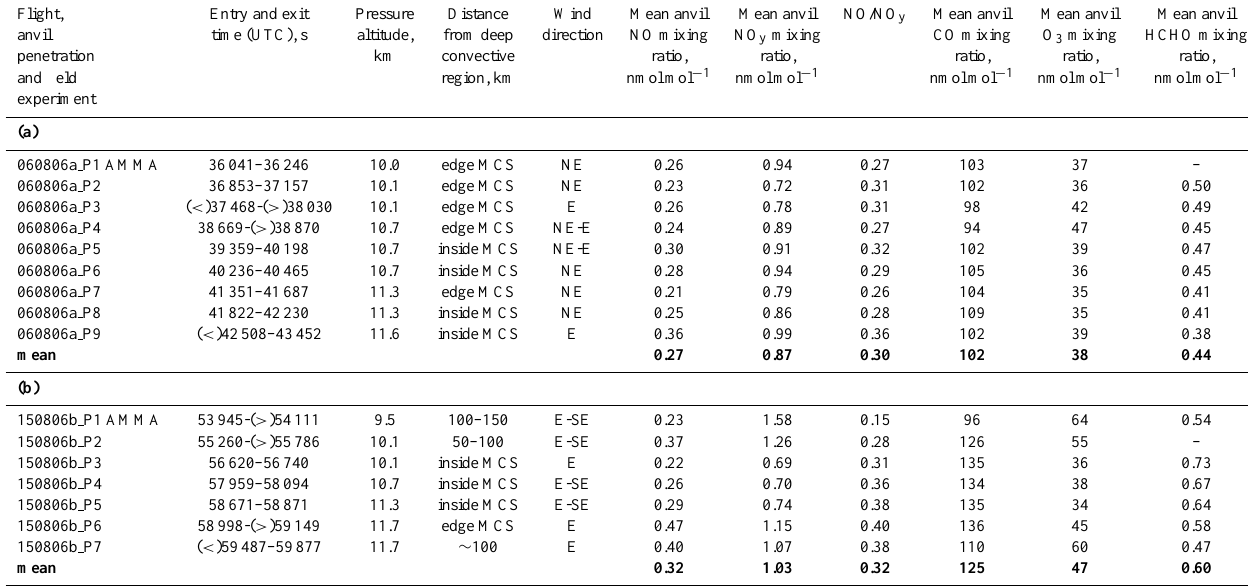
Table 2. Trace gas measurements in the anvil outflow of the MCS investigated on 6 and 15 August 2006.